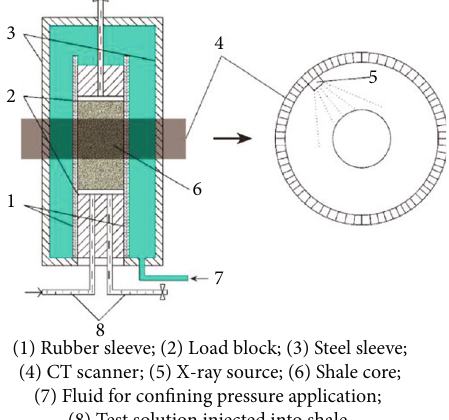
Figure 6: The CT scanner and X-ray core holder that were used by Zhang and Sheng [77, 78] and Zhang et al.